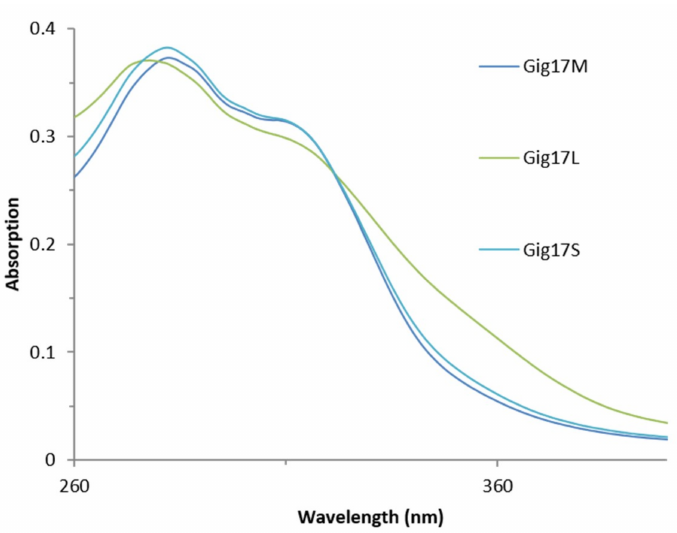
Figure 8. UV/Vis curves for lignins obtained from Miscanthus x giganteus. (Mixture: Gig17M. Leaf: Gig17L. Stem